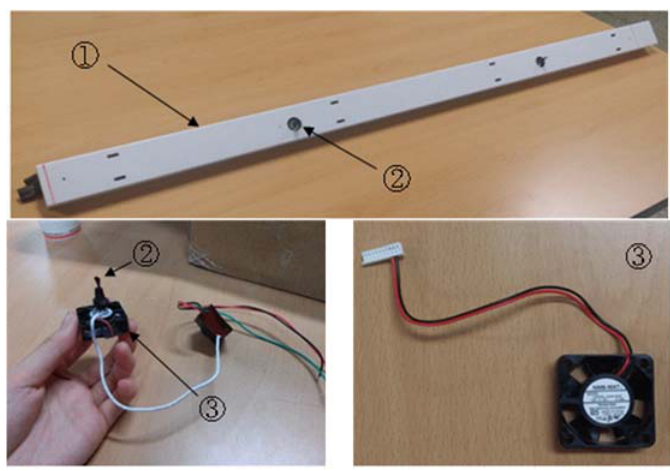
Figure 1. The anion generation system: (1) case, (2) anion generator, and (3) fan.